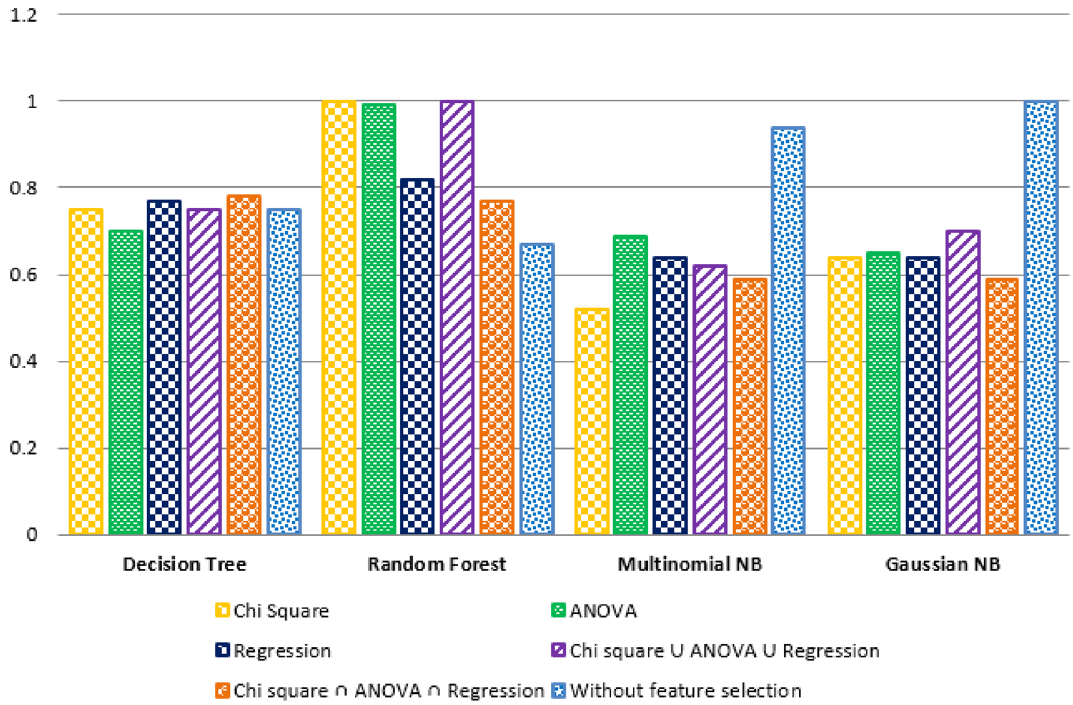
Figure 8. Comparative result of the different classifiers considering F1 score (feature selection and non-feature